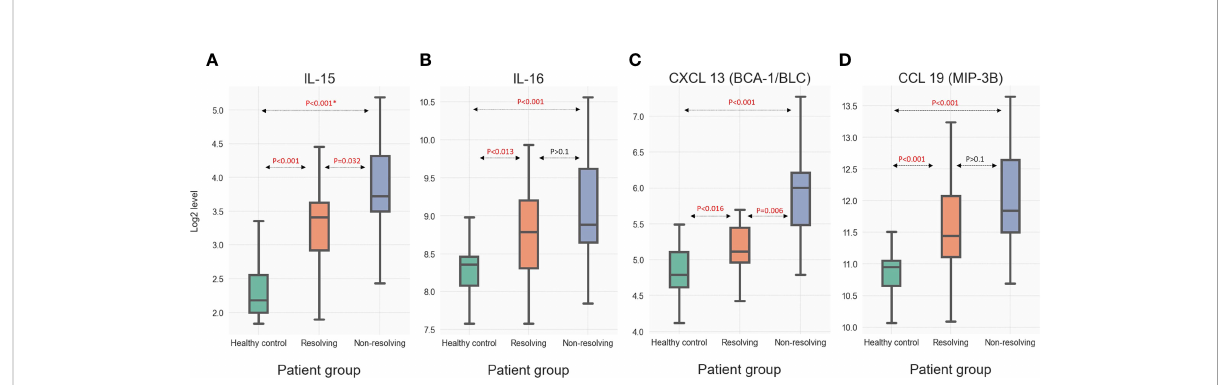
FIGURE 7 Quantitative measure of selected immune mediators including (A) IL-15 (B) IL-16 (C) CXCL 13 and (D) CCL29 in circulation of VC at 72 h as analyzed by the MSD assay. * For each mediator, the presented p-values were calculated through Dunn's post-hoc method. Then, the Benjamini-Hochberg method was used to further adjust the p-values from multiple